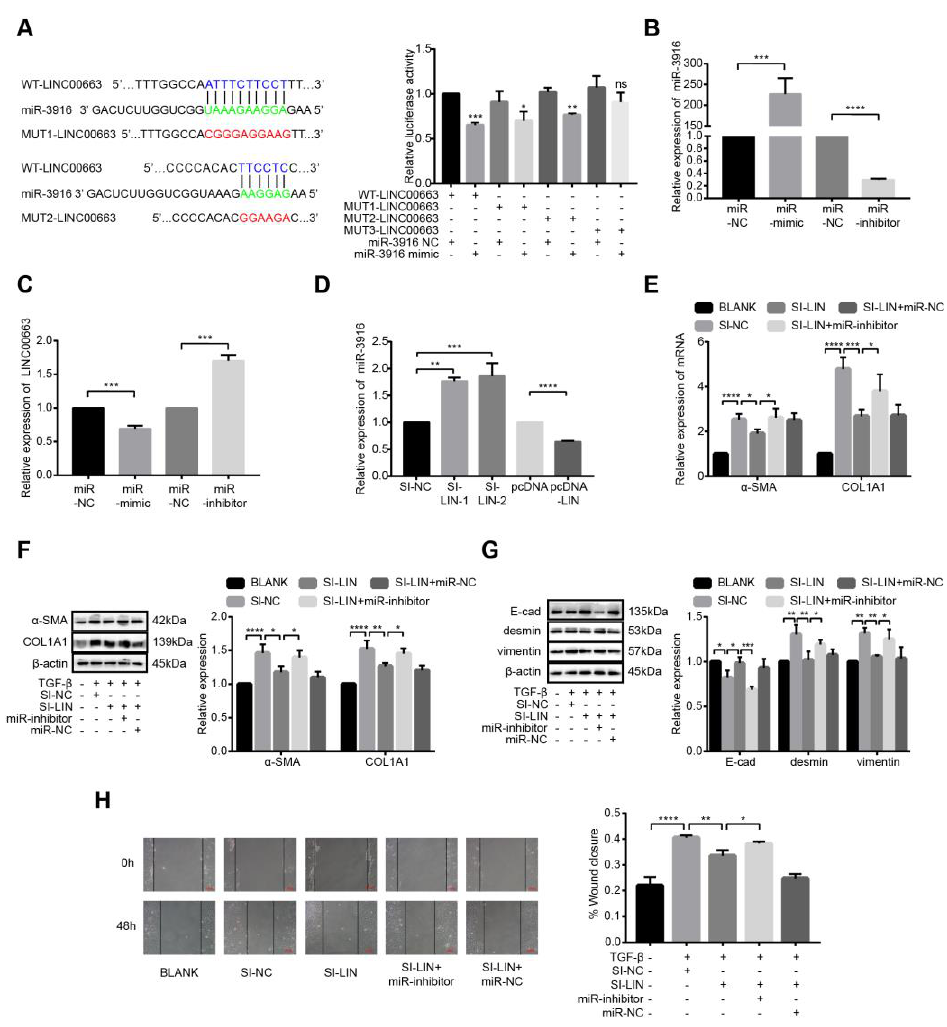
Figure 6. LINC00663 regulated activation, EMT, and migration of LX-2 cells through hsa-miR-3916. ( A ) A schematic diagram showing the sequences of wild-type and mutant LINC00663 with hsa-miR-3916. A dual-luciferase reporter gene assay was performed to identify the interaction between LINC00663 and hsa-miR-3916. The expression of hsa-miR-3916 ( B ) and LINC00663 ( C ) in LX-2 cells transfected with hsa-miR-3916 mimic (miR-mimic) and hsa-miR-3916 inhibitor (miR-inhibitor). ( D ) The expression of hsa-miR-3916 in LX-2 cells transfected with si-LINC00663 and pcDNA-LINC00663 (pcDNA-LIN). Relative expression of α -SMA and COL1A1 in LX-2 cells transfected with si-LIN, miR-inhibitor or with both detected by ( E ) RT-qPCR and ( F ) WB. ( G ) Relative expression of EMT proteins in LX-2 cells transfected with si-LIN, miR-inhibitor or with both detected by WB. ( H ) The effect of LINC00663 and hsa-miR-3916 on cell migration by LX-2 cells transfected with si-LIN, miR-inhibitor, or with both detected by wound healing assay. Scale bar = 100 μm. * p < 0.05, ** p < 0.01, *** p < 0.001, **** p < 0.0001. Each experiment was repeated three times and similar results were obtained. COL1A1, collagen type I alpha 1 chain; EMT, epithelial–mesenchymal transition; HSCs, hepatic stellate cells; miR, microRNA; siRNA, small interfering RNA; α -SMA, α -smooth muscle actin; WB, western